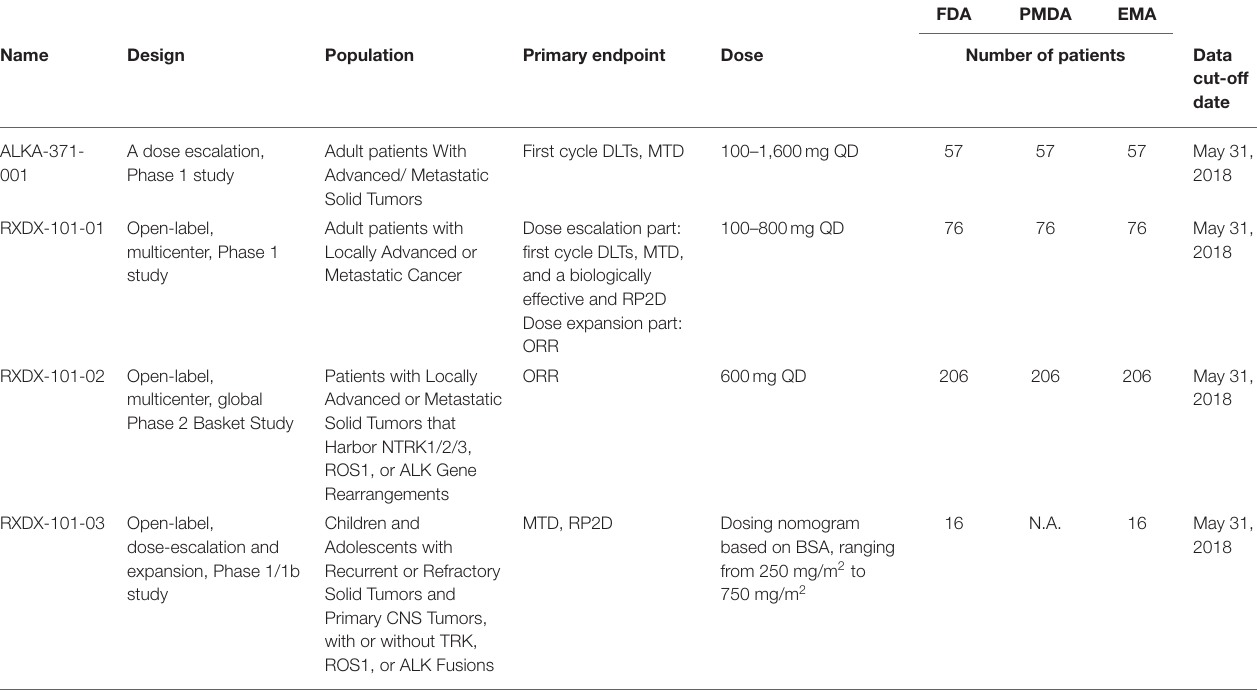
TABLE 3 | Clinical trials supporting the approval of entrectinib for the treatment of NTRK